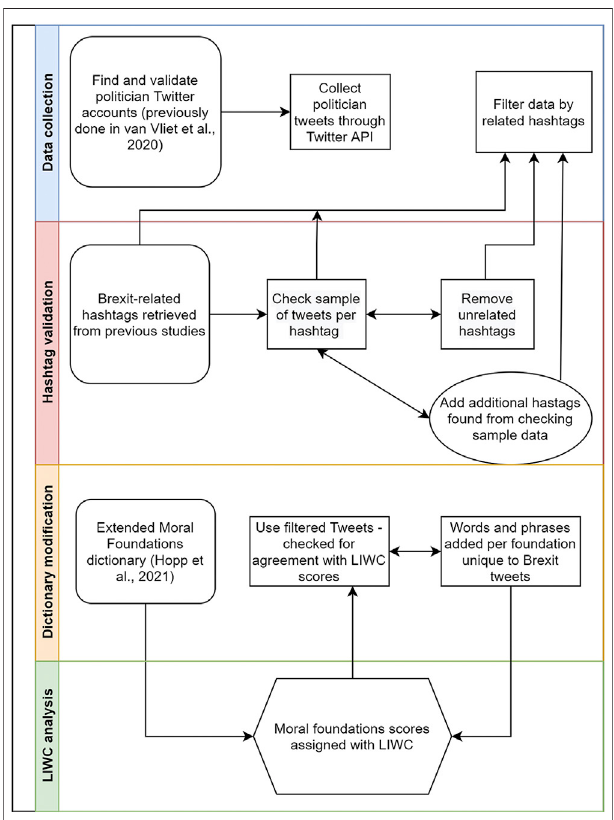
FIGURE 1 | Process diagram showing the iterative methods in hashtag selection and dictionary modi fi